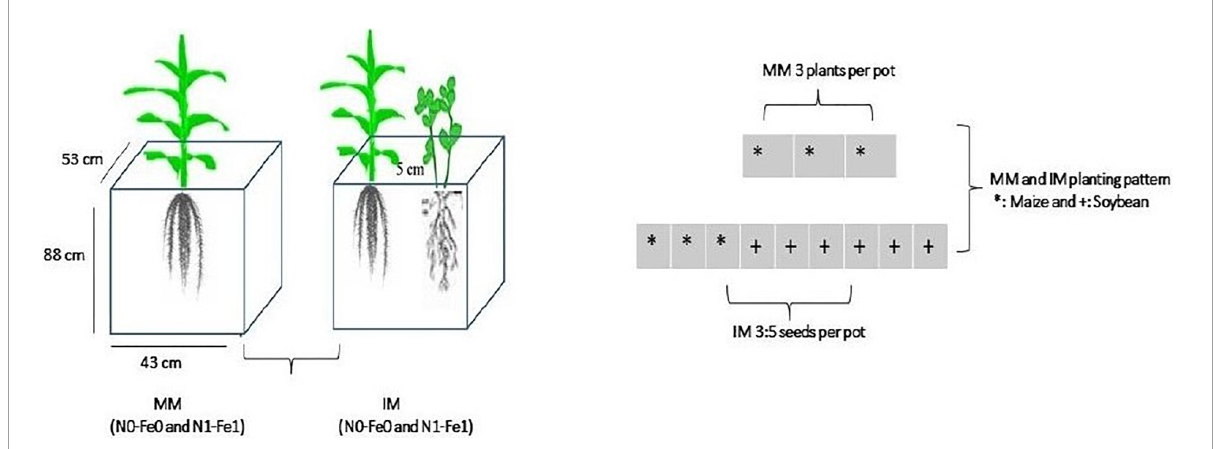
FIGURE1 Schematic diagram of the experiment. MM, maize monocropping; IM, maize intercropping; N0-Fe0, no nitrogen and iron fertilization; N1-Fe1, nitrogen and iron fertilizers applications; ∗ , maize crops and; +, soybean crops.